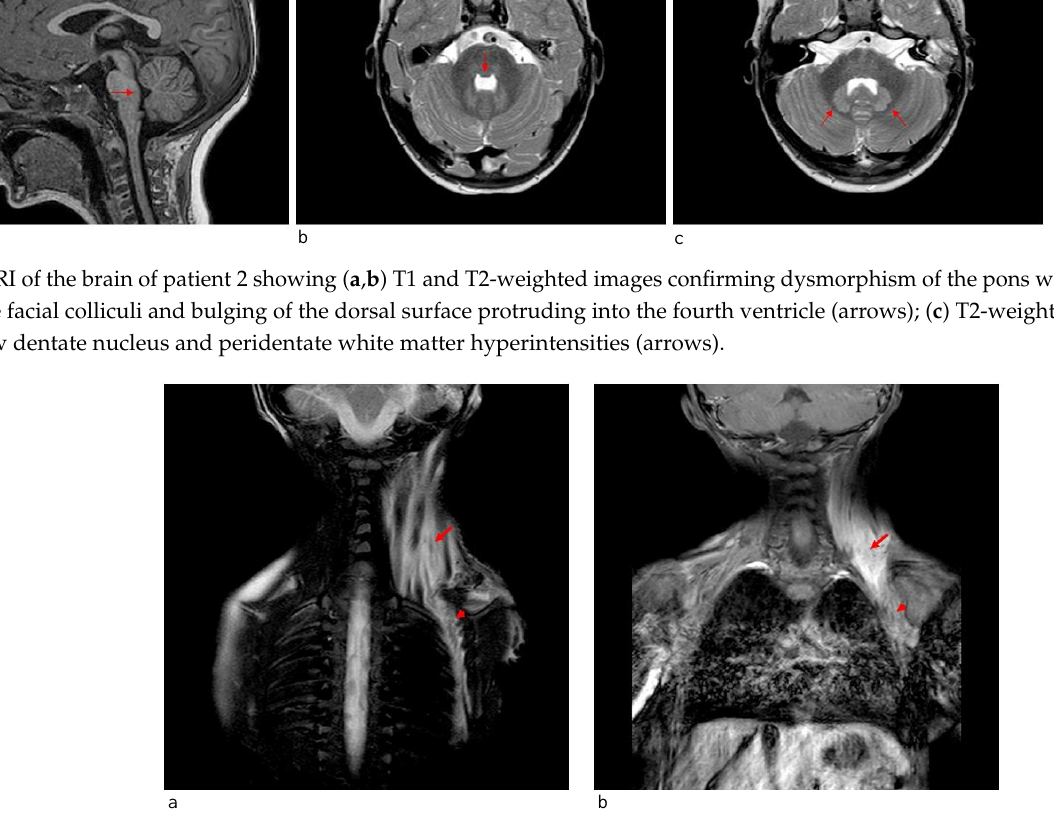
Figure 6. MRI of the cervicothoracic region of patient 2 showing: ( a ) STIR-coronal and ( b ) postcontrast T1 images revealing a diffuse hyperintense signal and contrast enhancement extending along the muscles and fascial planes of the neck (arrow) and thoracic wall (arrowhead).